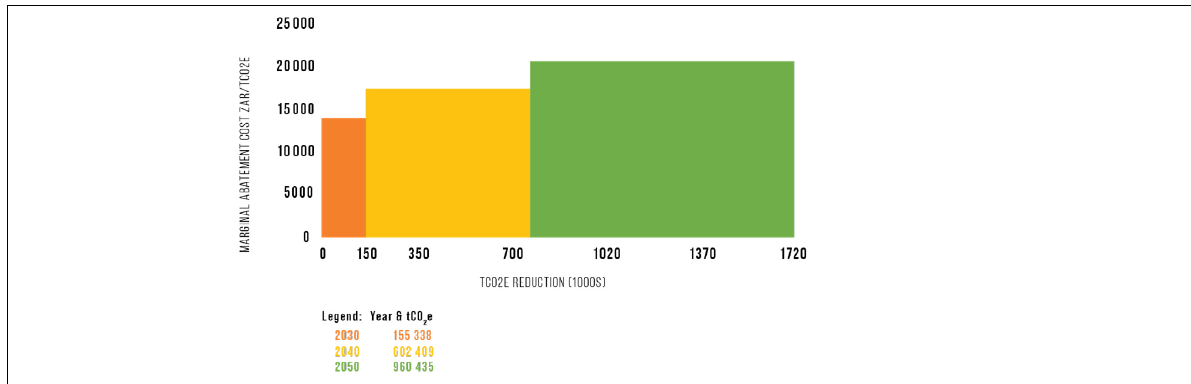
Figure 3: Marginal abatement cost curve for the building sector in 2050.